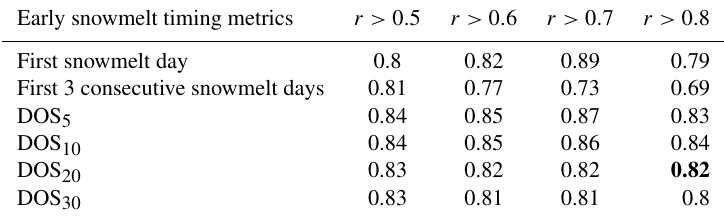
Table A3. Coefficient of determination ( R 2 ) for the site-averaged stepwise multiple linear regression, analogous to that presented in Fig. 7b, for different modeling decisions (correlation cutoff between hourly solar radiation and streamflow, r , and early snowmelt days metrics). DOS xx represents the date when the xx th percentile of snowmelt days occurs. The bolded number is associated with the stepwise MLR in Eq. (1) using DOS 20 .